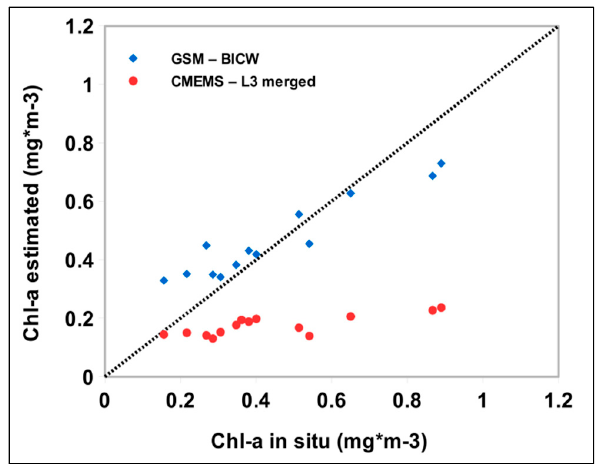
Figure 12. Scatter plot between in situ and satellite chl-a data. The blue rhombus are chl-a values obtained by GSM-BICW algorithm, while the red circles are related to the CMEMS-L3 product. The dashed line is the 1:1 line.